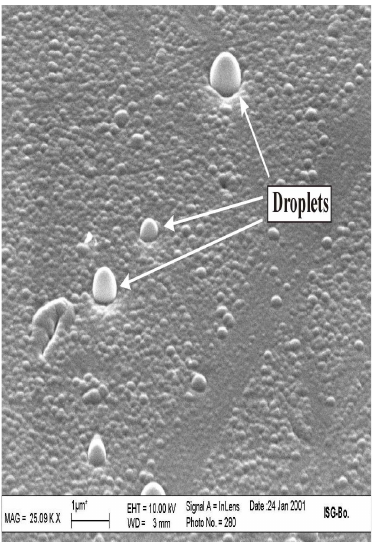
Figure 5 . SEM micrograph of the surface of the Pb 2+ -selective layer of the thin-film sensor array with chalcogenide glass material system of Pb-Ag-As-I-S.